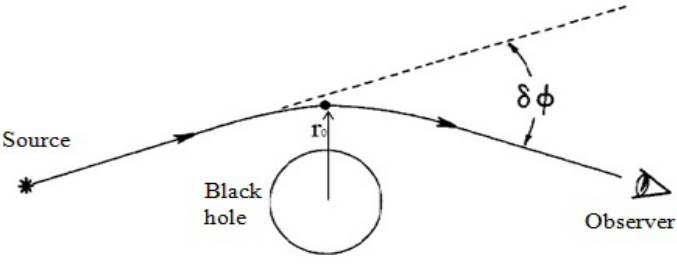
Figure 3. Gravitational deflection of light around a massive